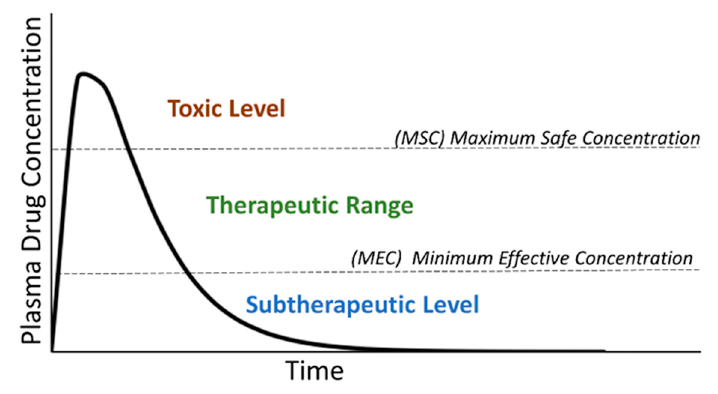
Figure 1. Drug concentration profile in plasma over time.